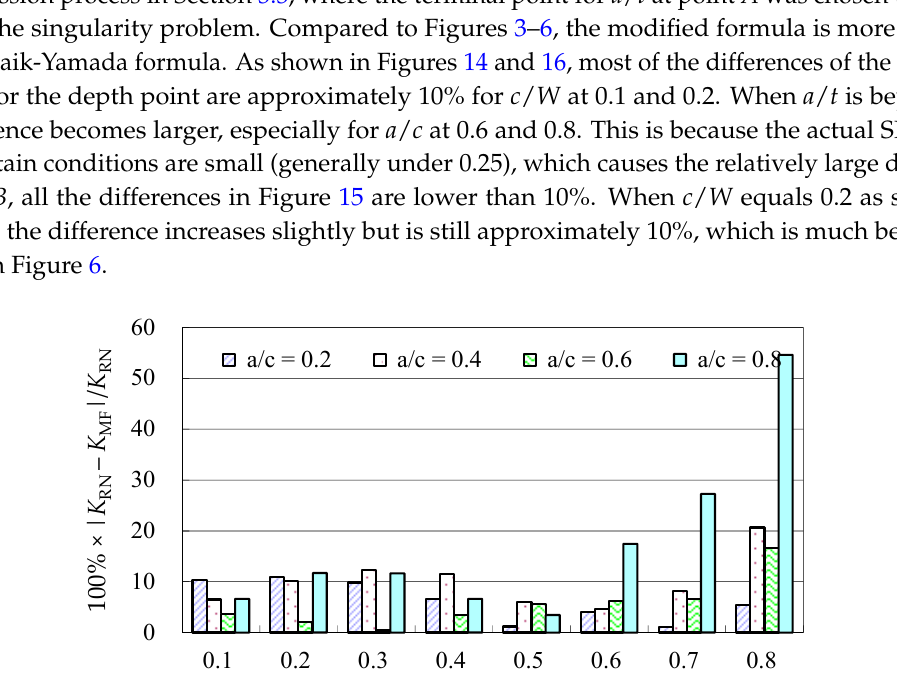
Figure 13. Modified formulae vs. the benchmark results ( a / c = 0.5). Table 2. Modified formulae vs. photo-elastic experiment data.